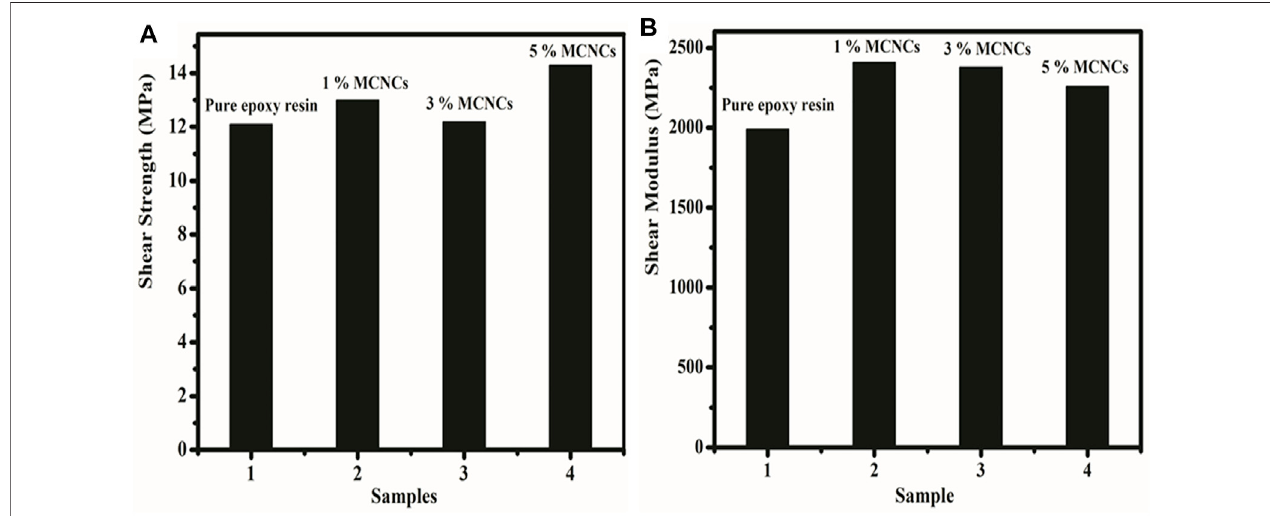
FIGURE 9 | (A) Shear strength and (B) shear modulus of pure epoxy resins and different concentrations (1%, 3%, and 5%) of MCNCs.